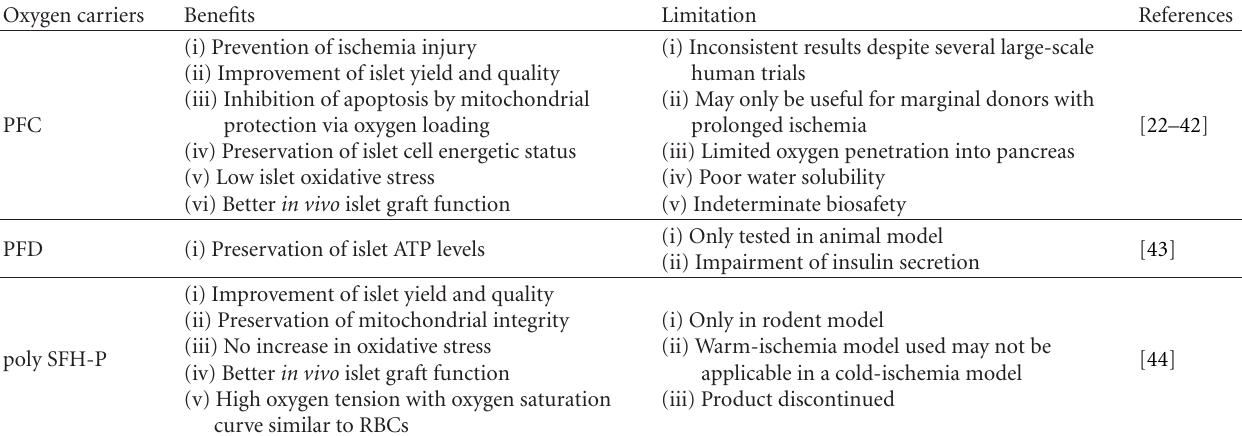
Table 1: Oxygen carriers used in pancreas organ preservation and islet